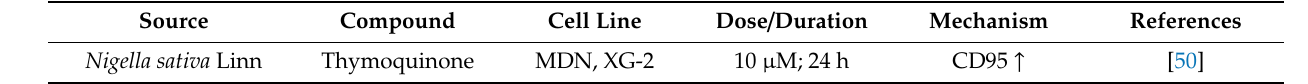
Table 2. Extrinsic pathway apoptosis inducing natural products.